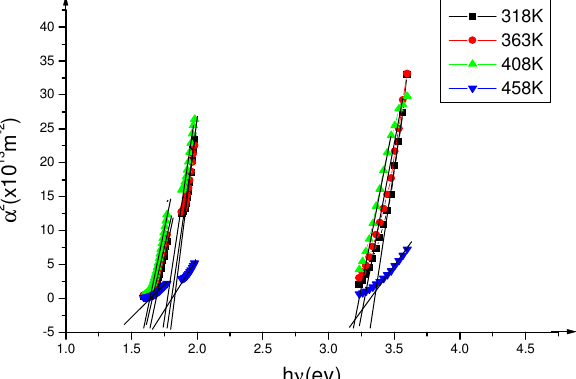
Figure 2 . Plot of α 2 vs . h ν for CoPc thin films deposited at substrate temperatures 318, 363, 408 and 458 °